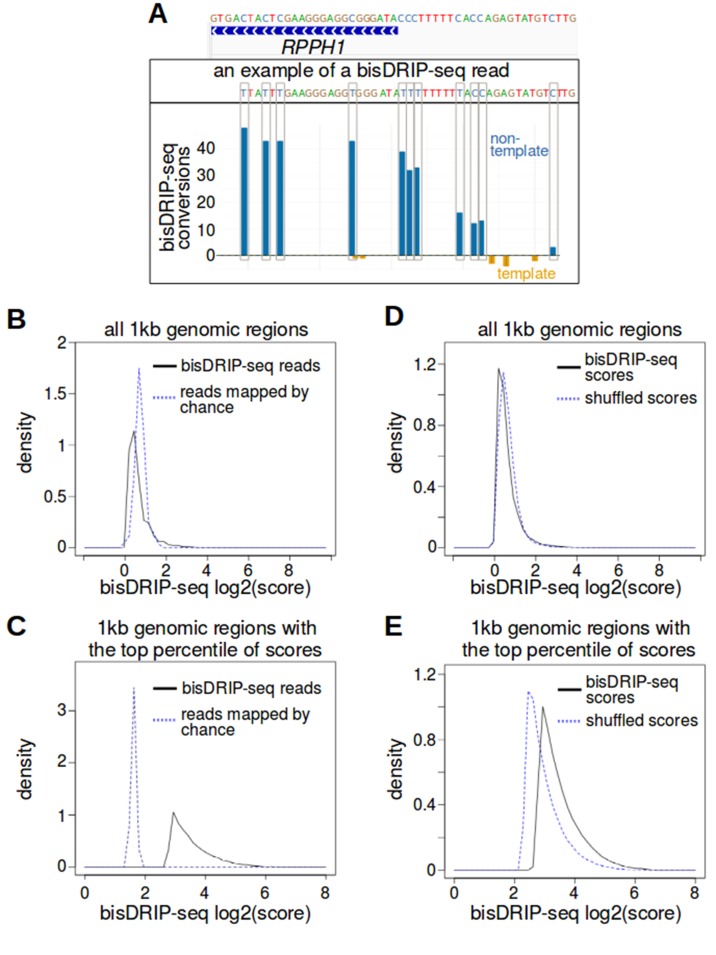
bisDRIP-seq identifies regions of single-stranded DNA.(A) Consecutive bisulfite conversions are observed in the genomic region surrounding RPPH1's transcription start site. The bisDRIP-seq bisulfite treatment should create consecutive cytosine-to-uracil conversions in regions of single-stranded DNA. We expected to observe this in individual reads located in single-stranded regions. We also expected to observe a high aggregated number of conversions within regions of DNA that were frequently single-stranded. As shown in Figure 1B, the entire RPPH1 gene appeared to preferentially contain single-stranded DNA on its non-template strand. Here we observe part of this region at higher resolution and in individual reads. At the top of the panel, a gene model is displayed of the genomic region located within 25 bp of the transcription start site of RPPH1. Above this gene model is the exact sequence of DNA in this region. Under the gene model of RPPH1, is the sequence of one of the reads that overlapped with the transcription start site of RPPH1. Within the sequence of the read, cytosines that were not converted by bisulfite are represented by a blue ‘C’. By contrast, putative bisulfite-converted cytosines are represented by a blue ‘T’. In this particular read, eight consecutive cytosines were converted near the transcription start site, while three consecutive cytosines were not converted further upstream of the transcription start site. This suggests that the read represented a region of DNA that was partially single-stranded and partially double-stranded immediately after cell lysis. In the lower plot, the total number of conversions on the template strand and non-template strand were plotted below the x-axis (orange) or above the x-axis (blue), respectively. Shown are the total number of conversions observed in all bisDRIP-seq samples (n = 13). Consecutive cytosines on the non-template strand had high numbers of conversion in the region immediately upstream of the transcription start site and in the region downstream of the transcription start site. This suggests that the conversions were due to the presence of single-stranded DNA in this region. (B,C) bisDRIP-seq scores are more clustered than expected if read location were determined through stochastic processes. Stochastic processes were modeled using a Monte Carlo simulation. In this simulation, all of the reads from a given sample were mapped to a randomly-assigned 1 kb region. This 1 kb region had to be within the same chromosome as the original read and it had to overlap with one bisDRIP-seq read. This process was repeated for all reads within each sample. Next, mean bisDRIP-seq scores were calculated for each 1 kb region in the genome using either real bisDRIP-seq reads (black, solid, n = 13) or using reads assigned to regions at random (blue, dashed, n = 13). We then compared the density of regions (y-axis) with a given mean bisDRIP-seq score (x-axis) for all regions (C) (n = 2956134) or just the regions that had the top percentile of scores (D) (n = 29561). The Monte Carlo simulation generated a larger proportion of regions with moderate scores, while the bisDRIP-seq scores from aligned reads were concentrated in a smaller subset of regions (p<2.2×10−16, Wilcoxon signed-rank test). This is consistent with bisDRIP-seq showing greater specificity than expected by chance. Source code for calculating bisDRIP-seq region scores can be found in Source code 2 and source code for Monte Carlo simulation can be found in Source code 3. (D,E) bisDRIP-seq scores are more clustered than expected if the bisDRIP-seq scores of reads were determined through stochastic processes. A ‘shuffled scores’ control was generated by randomly assigning bisDRIP-seq scores to reads from the same chromosome in a given sample. This was repeated across all chromosomes and across all samples (n = 13). Next, bisDRIP-seq scores were calculated for each 1 kb region in the genome using either the bisDRIP-seq scores originally calculated for each reads (black, solid) or using the shuffled scores (blue, dashed). We then compared the density of regions (y-axis) with a given mean bisDRIP-seq score (x-axis, n = 13) for all regions (E) (n = 2956134) or just the regions that had the top percentile of scores (F) (n = 29561). The Monte Carlo simulation generated a larger proportion of regions with moderate scores, while the bisDRIP-seq scores generated from experiments were more concentrated in the regions with the highest scores (p<2.2×10−16, Wilcoxon signed-rank test). This suggests that the intensity of bisDRIP-seq score is informative and was not just due to stochastic processes. Source code for calculating bisDRIP-seq region scores can be found in Source code 2 and source code for shuffled scores Monte Carlo simulations can be found in Source code 4.